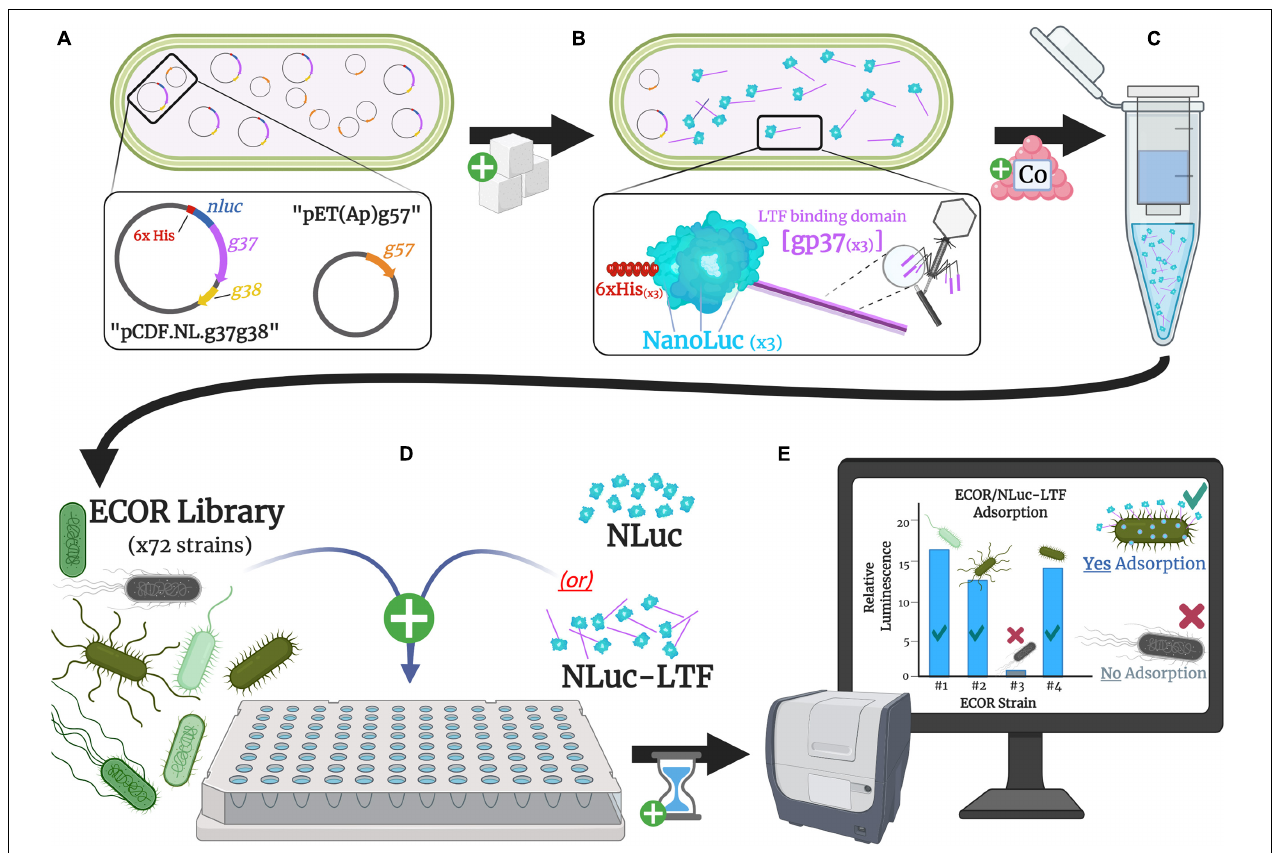
FIGURE 2 | Graphical representation of experimental design. (A) A dual-plasmid expression system produced T4’s general trimerization chaperone (gp57A), LTF-specific chaperone (gp38), and bioluminescent fusion protein (NLuc-LTF). (B) Proteins were produced in Escherichia coli DE3 cells using 0.1 mM IPTG, before being (C) isolated and purified by targeting N-terminal Histidine tags with a cobalt resin. (D) Respective sample wells were loaded with 200 µ L of a bacterial strain plus 200 ng of NLuc-LTF, incubated at room temperature for 30 min, vacuum-filtered to trap bacterial cells using 0.22 µ m filters at the bottom of each well, and washed three times with phosphate buffered saline (PBS) to remove unbound proteins. (E) Thirty microliters of NanoGlo substrate was added to relevant wells, and bioluminescent output was evaluated in a plate reader 20–30 min later.